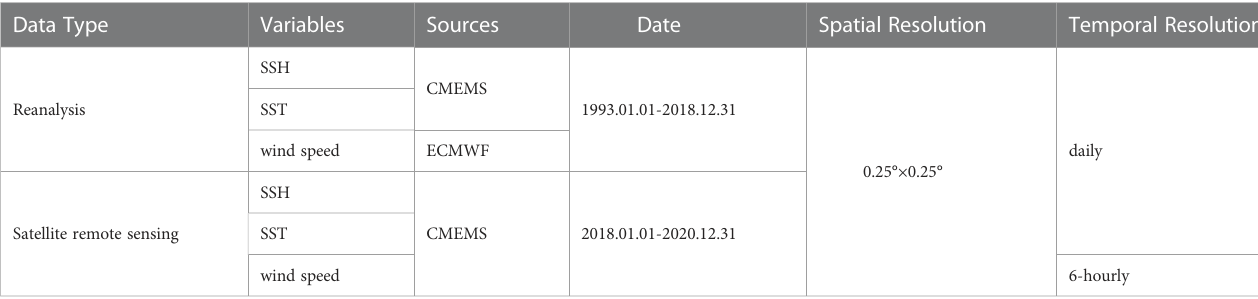
TABLE 1 Description of reanalysis and satellite remote sensing data.